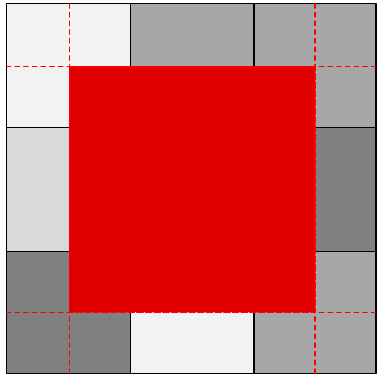
Figure 1. Illustration of the 7.5 m row and column shifts that occur between the 15-m panchromatic (gray) and the 30-m reflective band (red) Landsat-8 pixels.